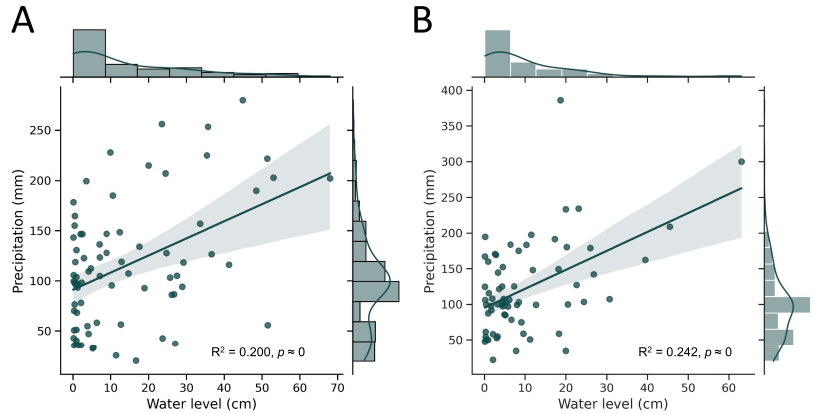
Figure 6. ( A , B ) Relationships between the water level of the Pivka River (measured daily) and precipitation on a regression plot in 2017 and 2021, respectively.